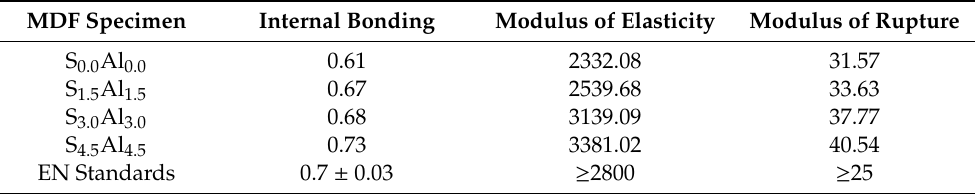
Table 9. The Final mechanical properties of 16 mm MDF samples for di ff erent concentrations of alumina